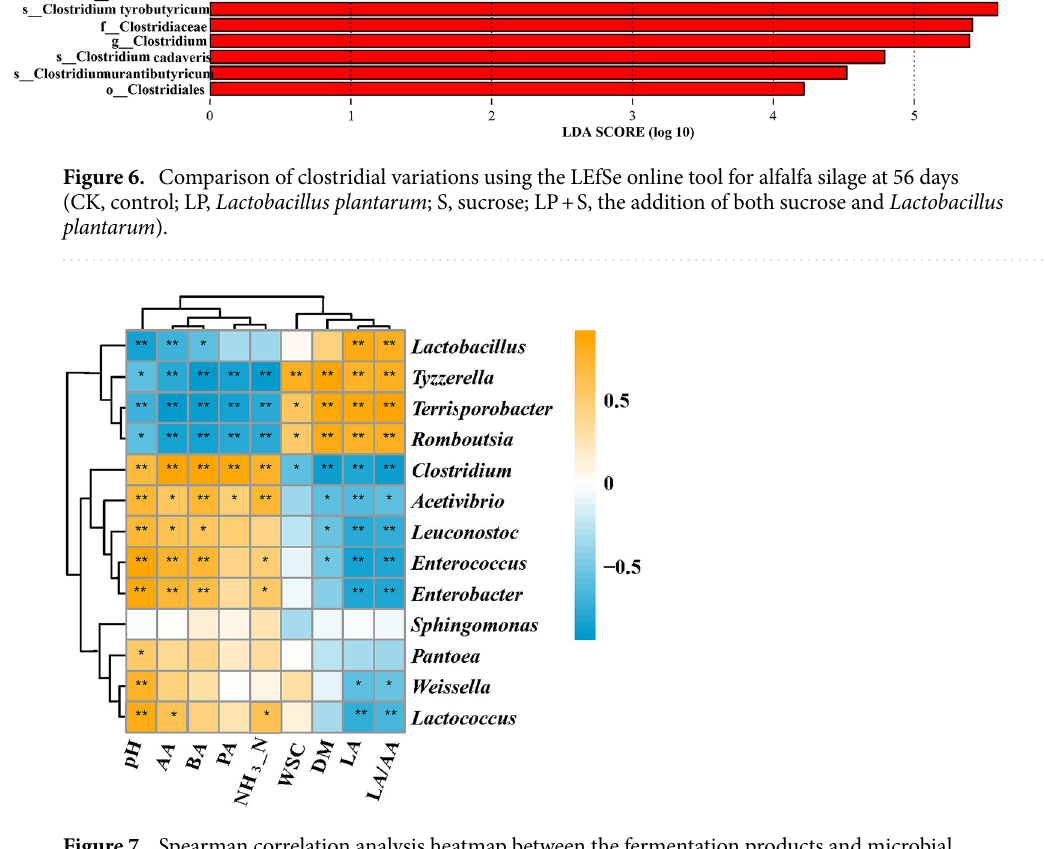
Figure 7. Spearman correlation analysis heatmap between the fermentation products and microbial community; **highly significant correlation at the 0.01 level; *highly significant correlation at the 0.05